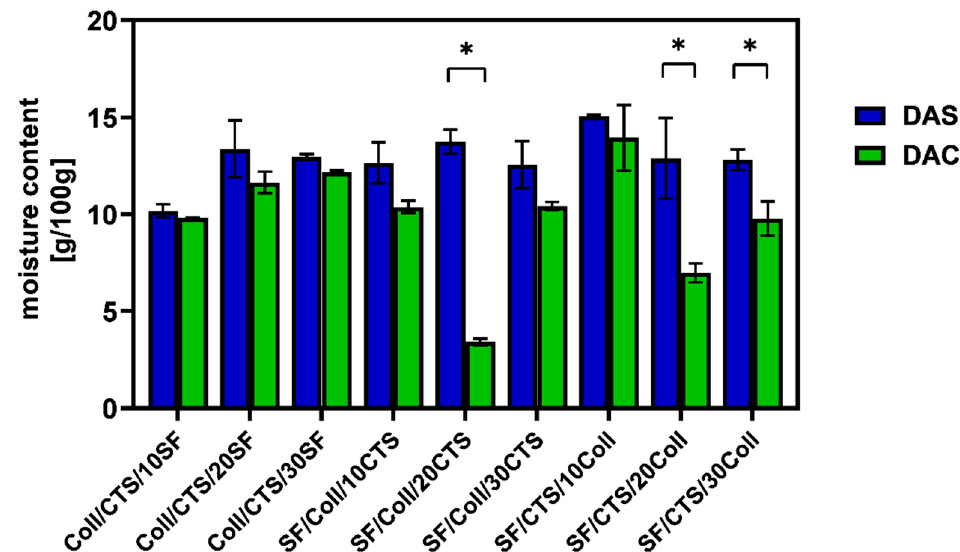
Figure 7. The results of moisture content of the scaffold cross-linked with dialdehyde starch (DAS) and dialdehyde chitosan (DAC). Results are presented as mean ± standard error of the mean (* p ≤ 0.05 between cross-linkers, according to one-way ANOVA with Holm–Sidak post hoc test, GraphPad Prism 8.0.1.244).